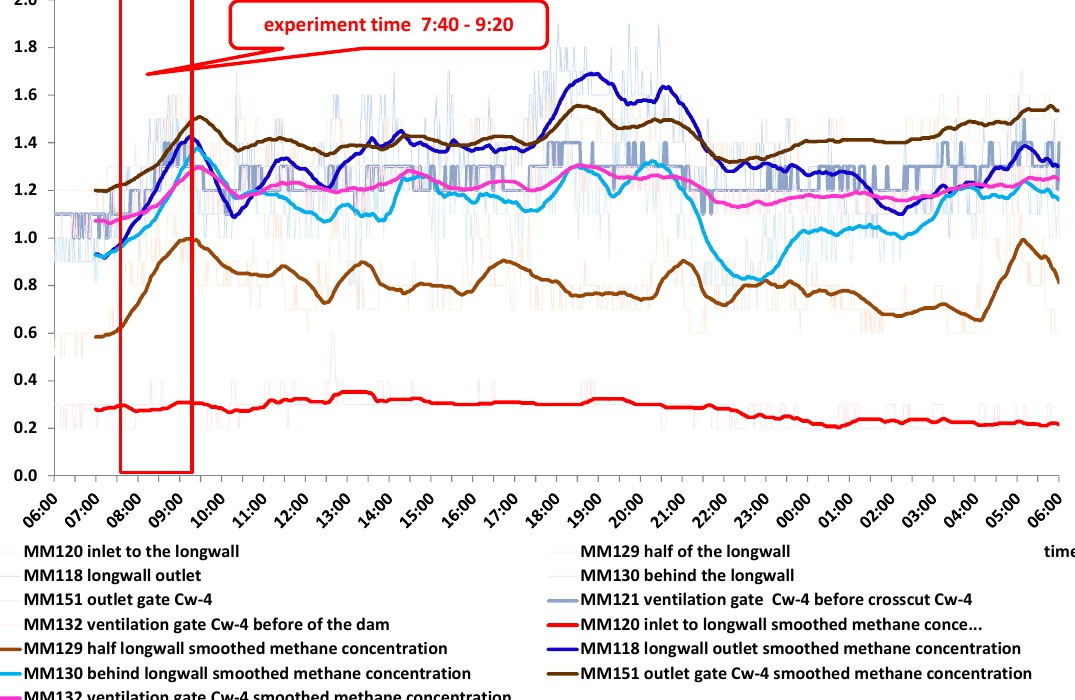
Figure 4. Smoothed methane concentration data for the longwall Cw-4 area.